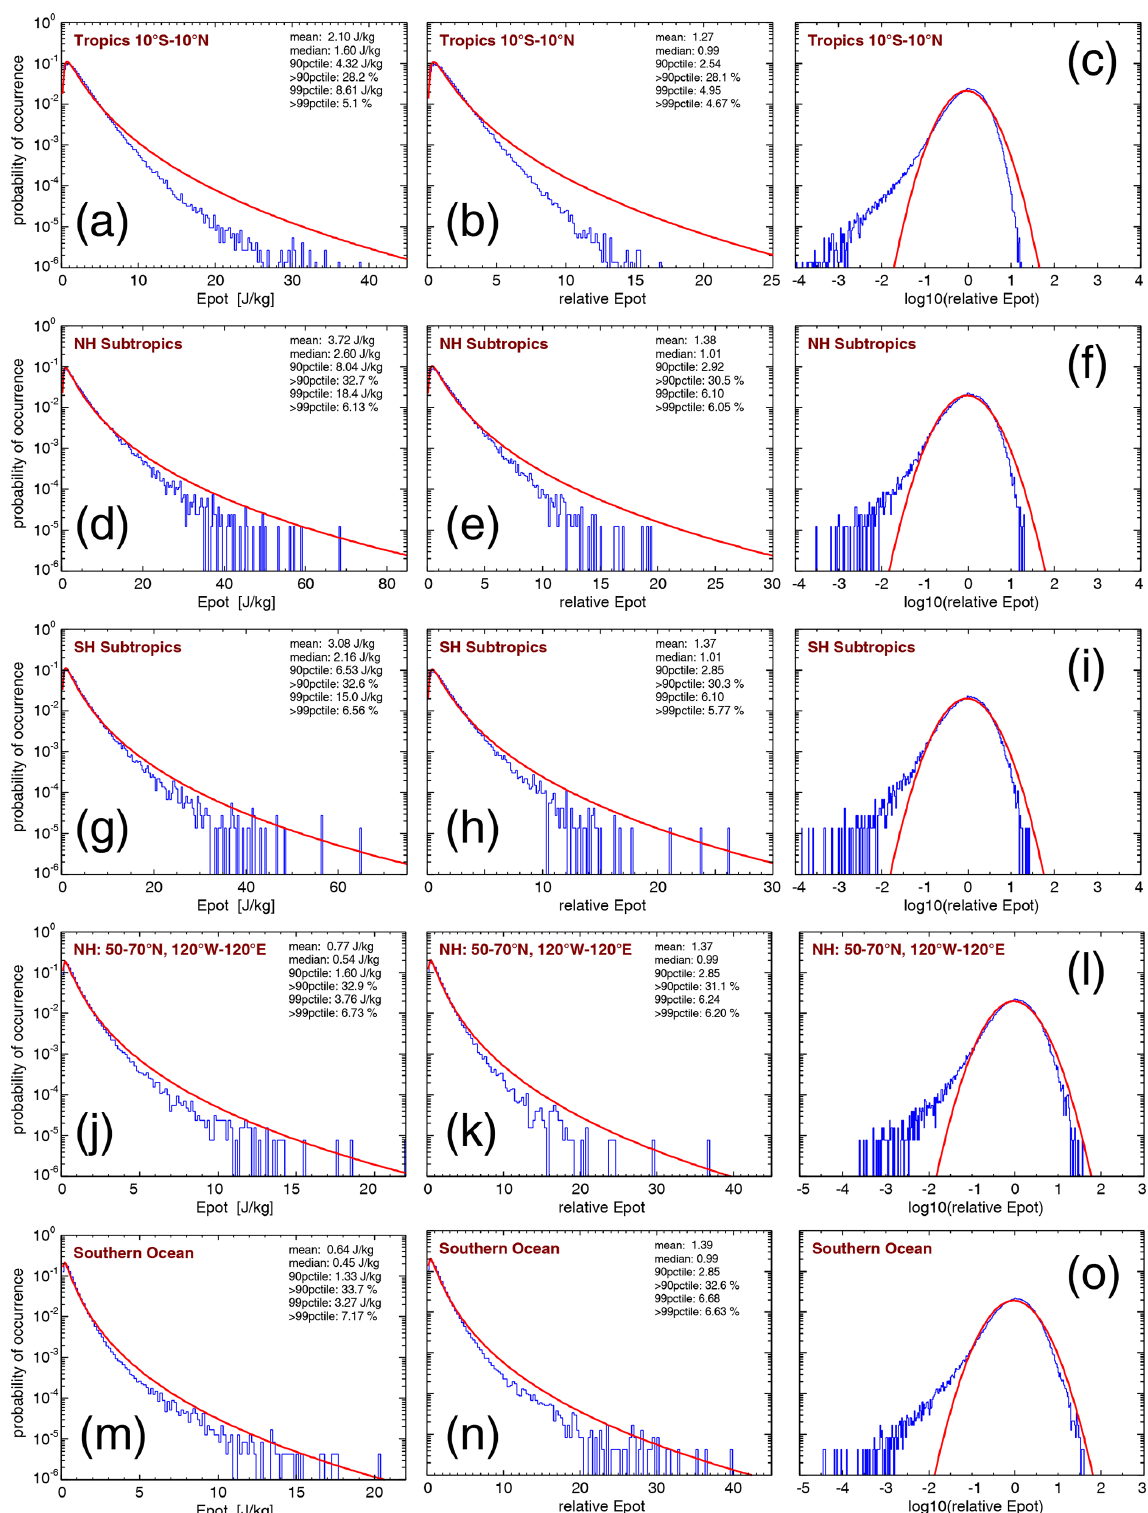
Figure 9. Same as Fig. 7 but for gravity wave potential energies ( E pot ).